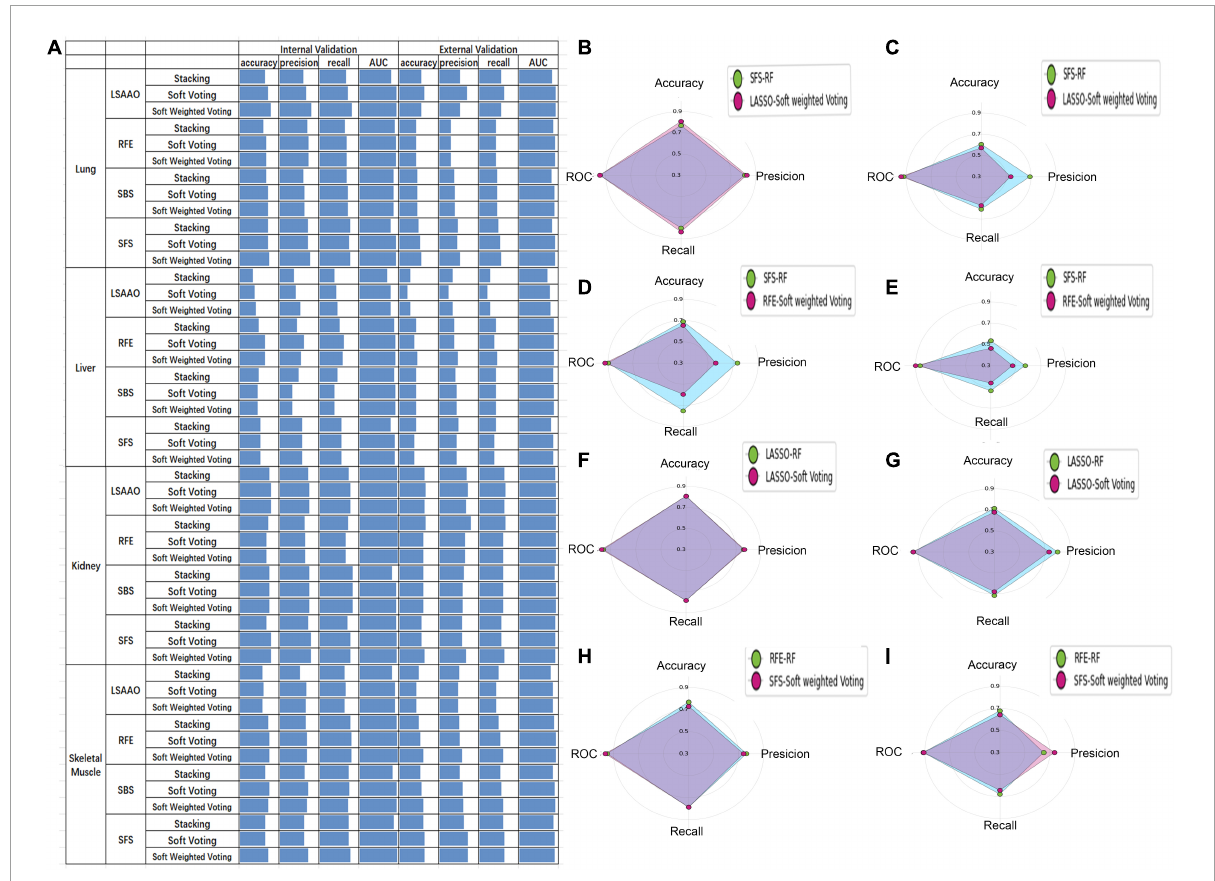
FIGURE6 The prediction performance of ensemble model and best sub-model based on single organ. (A) Histogram performance of internal and external validation of four organs cross-combining of four feature selection methods and three ensemble models. (B) Radar map of SFS-RF and LSAAO-soft-weighted voting based on internal validation of lung. (C) Radar map of SFS-RF and LSAAO-soft-weighted voting based on external validation of lung. (D) Radar map of SFS-RF and RFE-soft-weighted voting based on internal validation of liver. (E) Radar map of SFS-RF and RFE-soft-weighted voting based on external validation of liver. (F) Radar map of LSAAO-RF and LSAAO-soft voting based on internal validation of kidney. (G) Radar map of LSAAO-RF and LSAAO-soft voting based on external validation of kidney. (H) Radar map of RFE-RF and SFS-soft-weighted voting based on internal validation of skeletal muscle. (I) Radar map of RFE-RF and SFS-soft-weighted voting based on external validation of skeletal